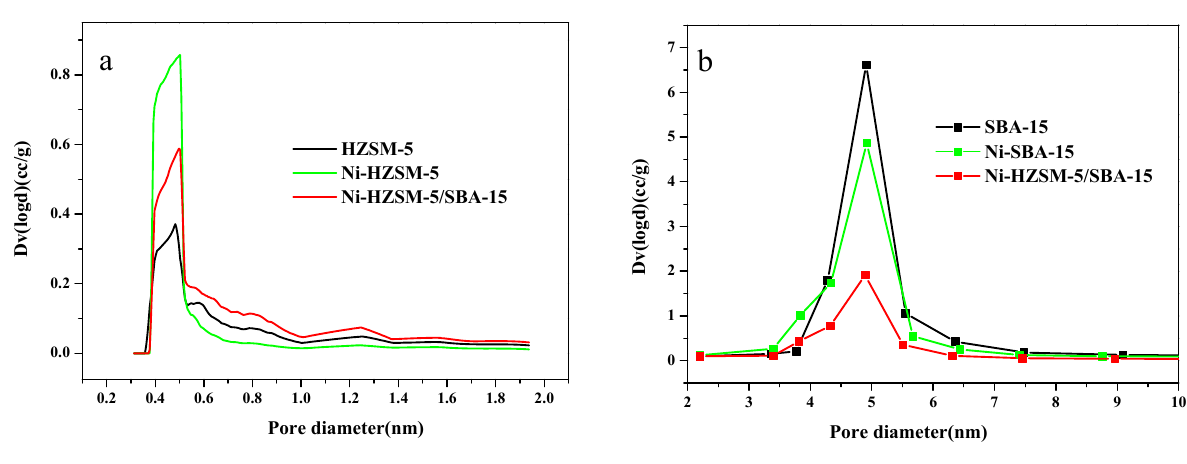
Figure 1. Pore diameter distribution of catalysts in ( a ) micropores; ( b ) mesopores. Figure 2 represented the X-ray diffractogram of catalysts synthesized from HZSM-5